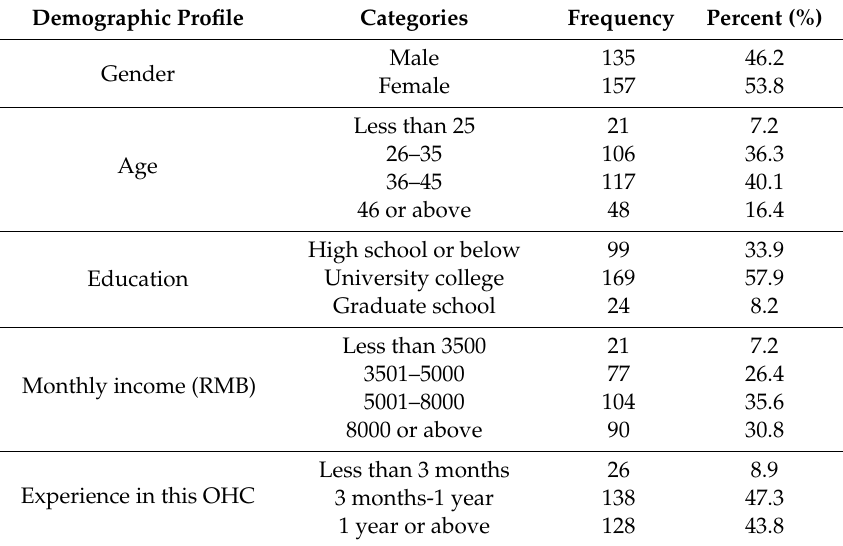
Table 3. Demographic characteristics of survey participants ( n =